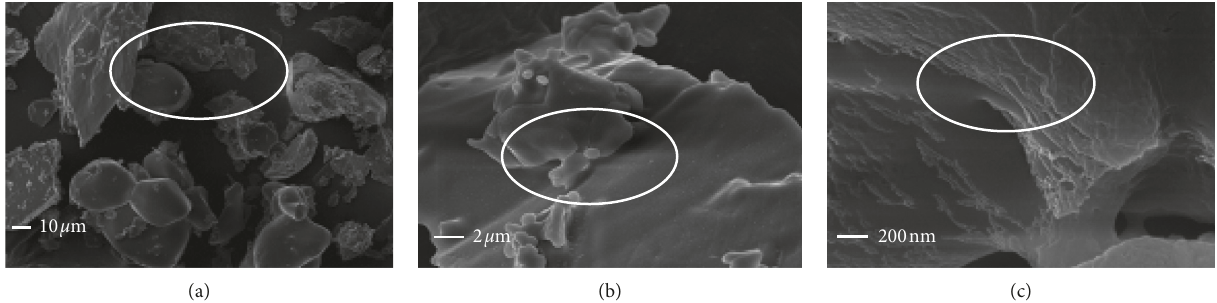
Figure 3: The images of KNO 3 under different ratios of the SEM setup.